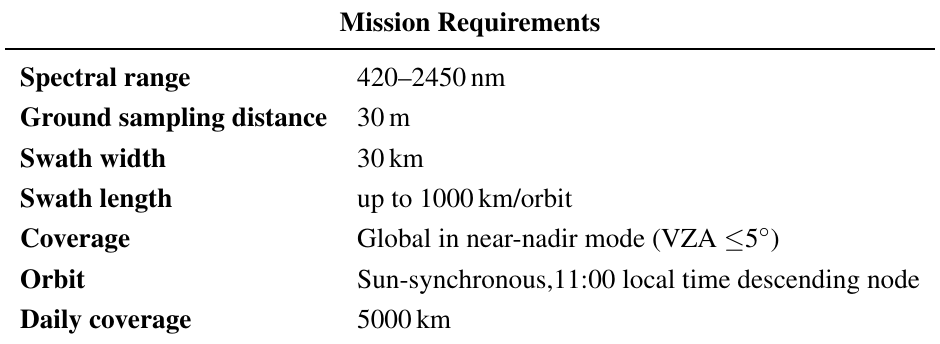
Table 1. Selected EnMAP mission and instrument specifications. The reference radiance level for the definition of signal-to-noise ratio (SNR) figures is 30% surface albedo, 30 ◦ Sun zenith angle, 0.5 km above sea level and 21 km atmospheric visibility. VZA stands for view zenith angle, VNIR for visible near-infrared and SWIR for shortwave